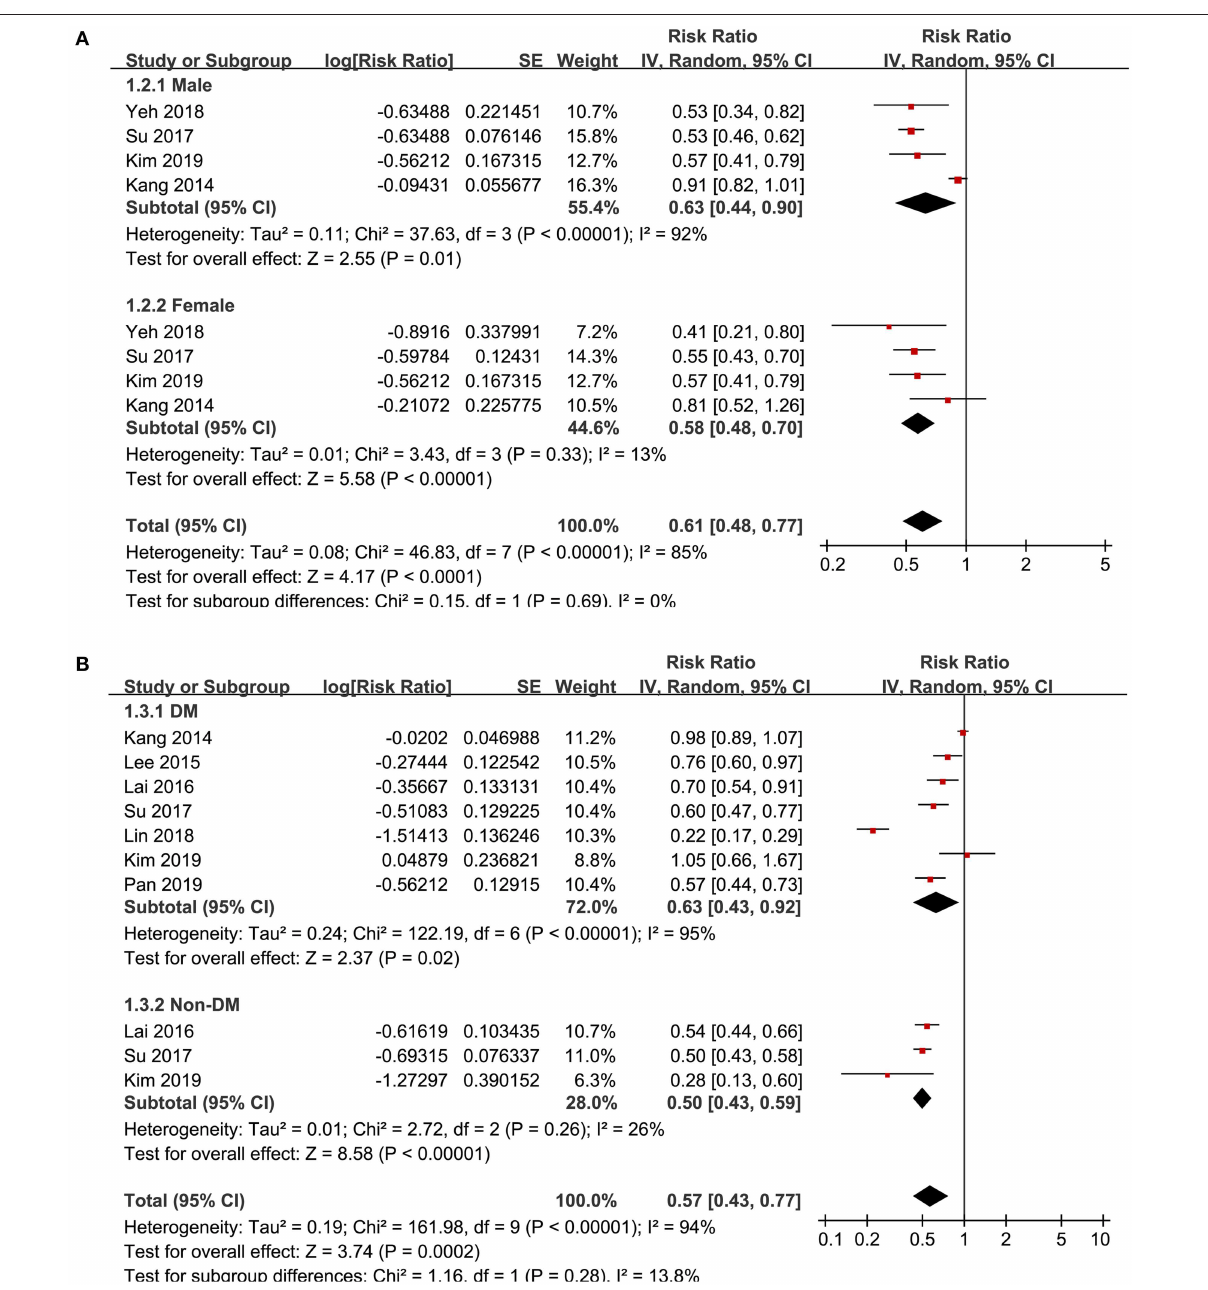
FIGURE 3 | Subgroup analyses for the association between statin use and active tuberculosis infection. (A) Subgroup analyses according to the gender of the participants; and (B) subgroup analyses according to the diabetic status of the